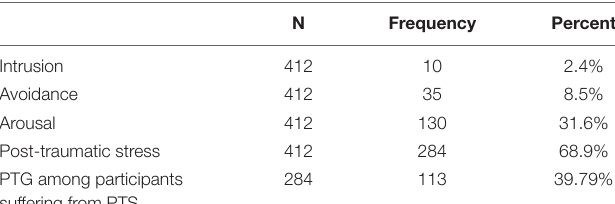
TABLE 2 | Prevalence of post-traumatic stress (PTS) and post-traumatic growth (PTG) in the present sample.